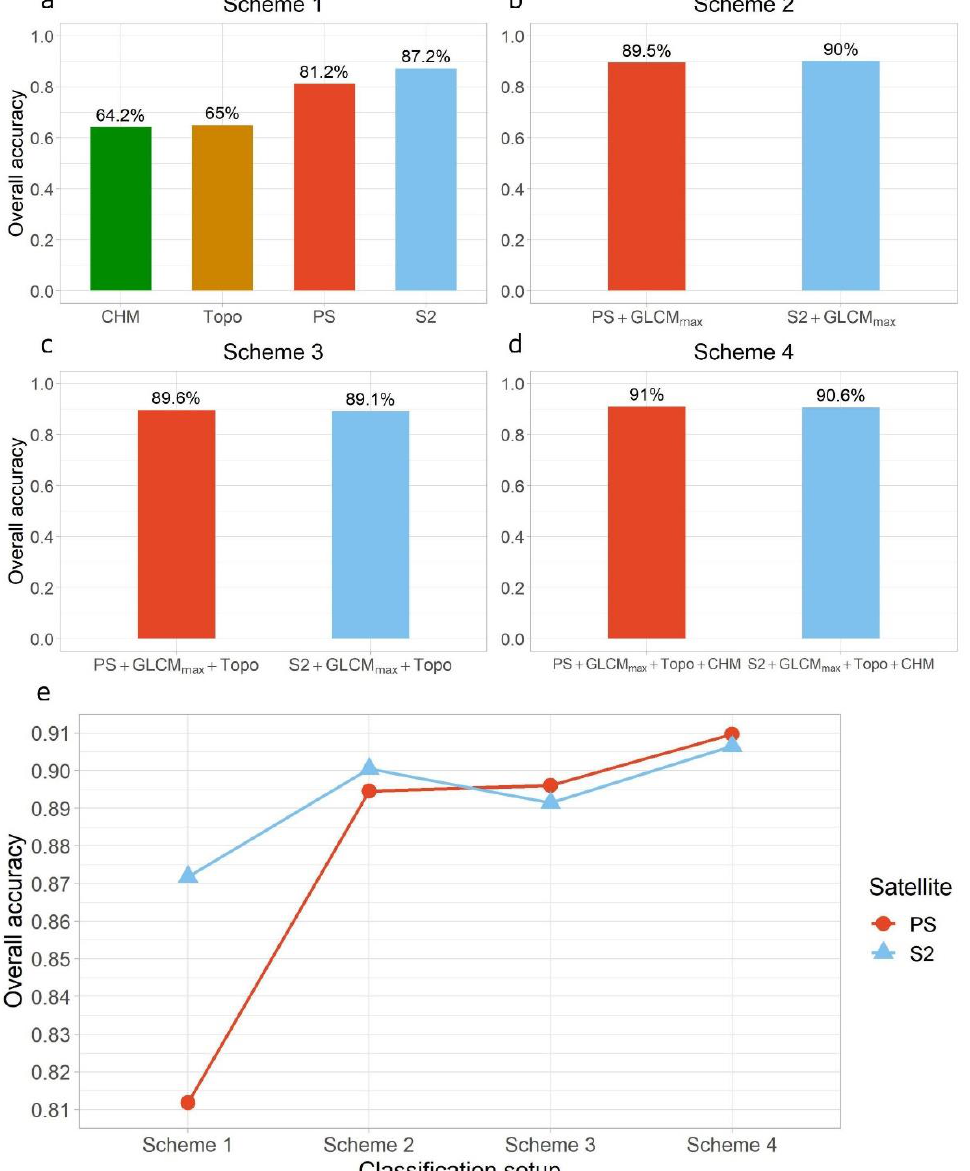
Figure 5. Overall accuracies of classification results for each feature space in: ( a ) classification scheme 1; ( b ) classification scheme 2; ( c ) classification scheme 3; ( d ) classification scheme 4 and ( e ) overall accuracy of PlanetScope and Sentinel-2 feature spaces in classification schemes 1 – 4.